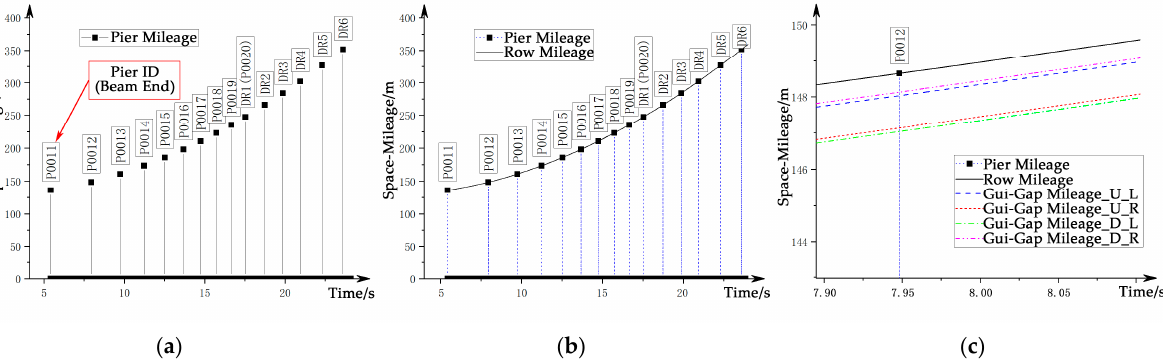
Figure 9. Processing of the locating signal: ( a ) locating result at beam ends; ( b ) locating results inside beams; ( c ) locating results for guidance-gap.